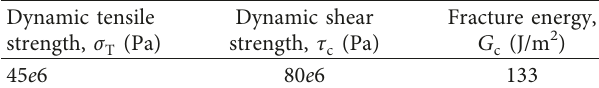
Table 4: Strength parameters of